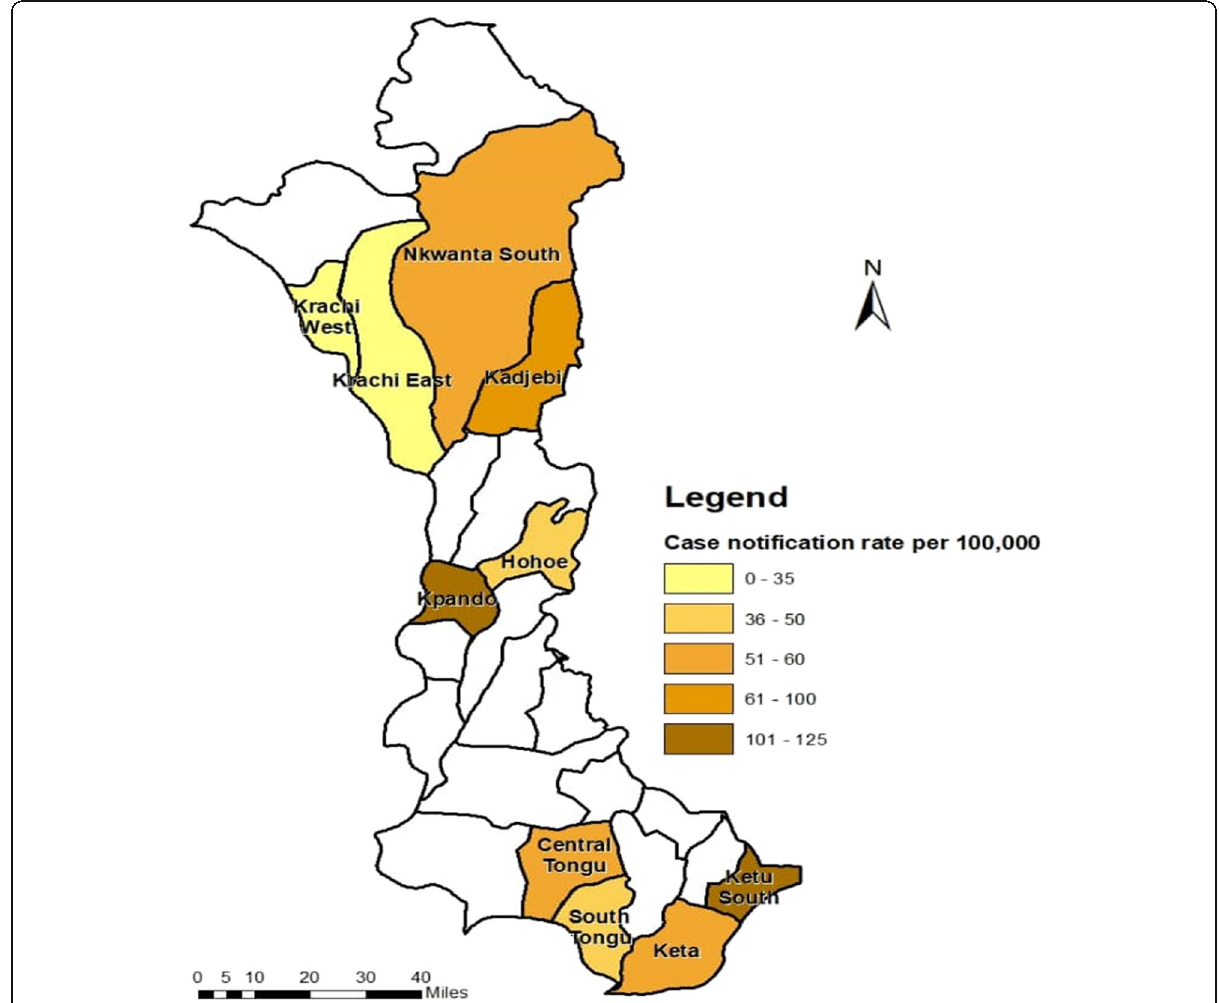
Fig. 2 TB Cases Notification Rate (all forms) by District, 2013 –